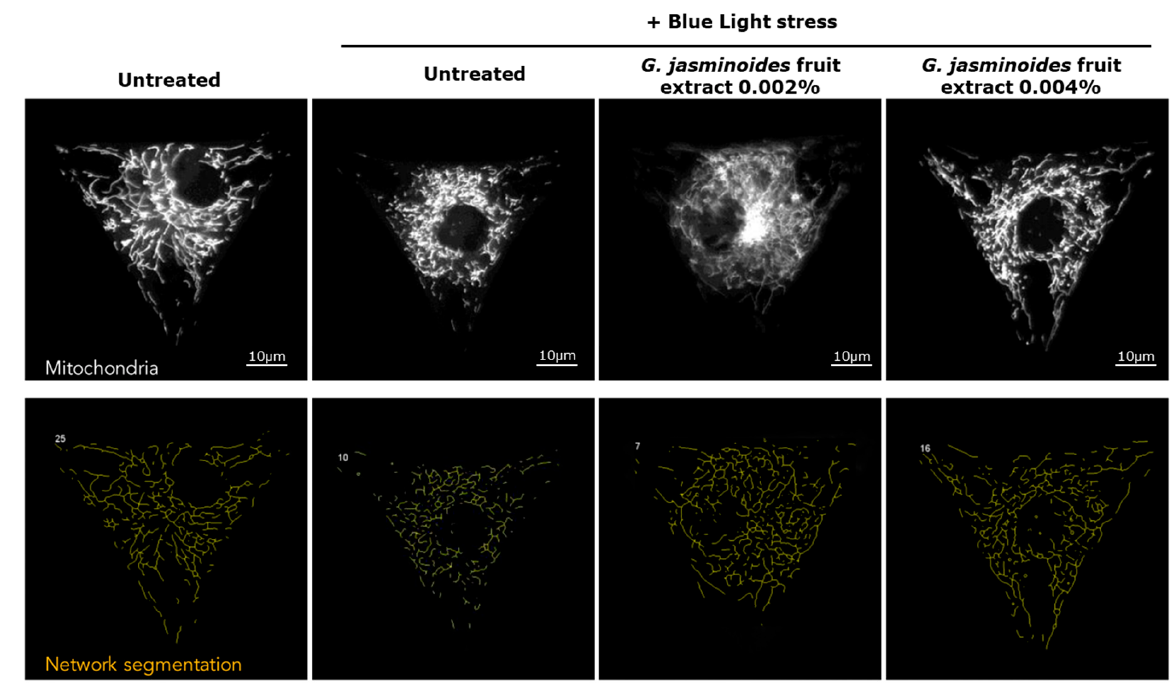
Figure 2. ( Top panel) Representative images of mitochondrial network staining in normal human dermal fibroblasts that are either pre-treated or not pre-treated with the extract for 24 h. The blue light stress corresponds to irradiation at 447 nm for 1 h at 20 J/cm 2 . ( Bottom panel ) Network segmentation obtained from the staining. Magnification 40×.